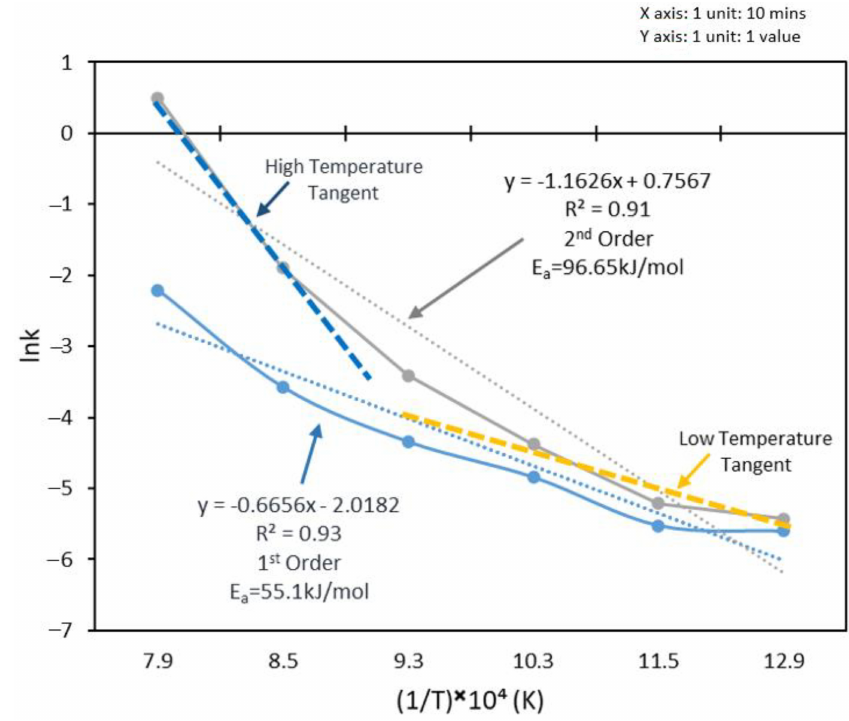
Figure 20. Arrhenius plot of different reaction orders under H 2